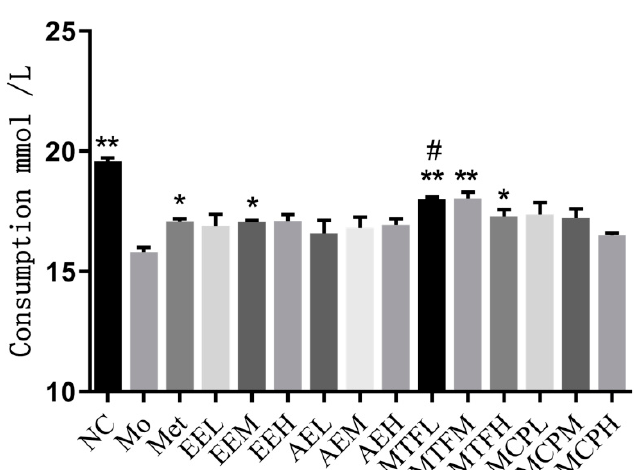
Figure 9. Effects of MCB extracts on glucose intake in IR-HepG2 cells. NC: control group, Mo: model group, Met: drug group, EE: ethanol extract, AE: aqueous extract, MTF: total flavonoids, MCP: crude polysaccharides. “*” and “**” represent p < 0.05 and p < 0.01 compared with the Mo group, respectively. “#” indicates p < 0.05 compared with the Met group.